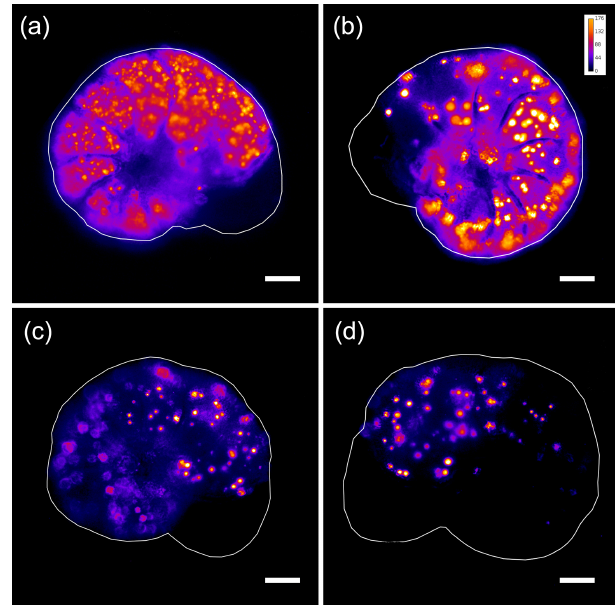
Figure 2. Illustration of Haynesina germanica chloroplast content at the beginning (a) and at the end of the experiment for the three ex- perimental conditions, Dark (b) , Low Light (c) and High Light (d) . Higher colour scale values correspond to foraminifera emitting more fluorescence and likely containing more chlorophyll a ; flu- orescence in pixel values between 0 and 255, (scale bar =